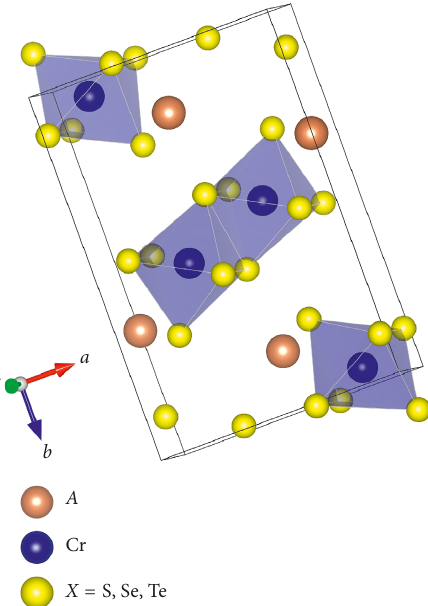
Figure 1: Visualization of the unit cell of the NH structure, which contains edge-sharing octahedra.